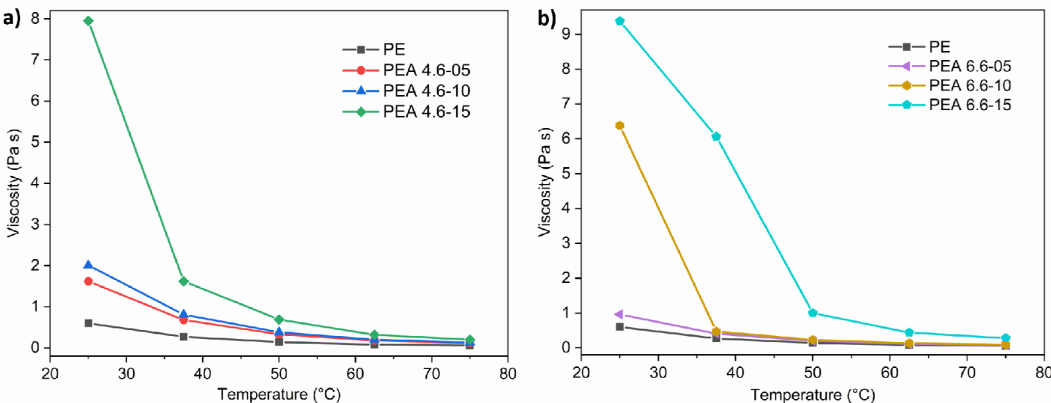
Figure 4. Temperature dependency of the viscosity of resins synthesized in the course of this study with ( a ) amido diol 4.6 and ( b ) amido diol